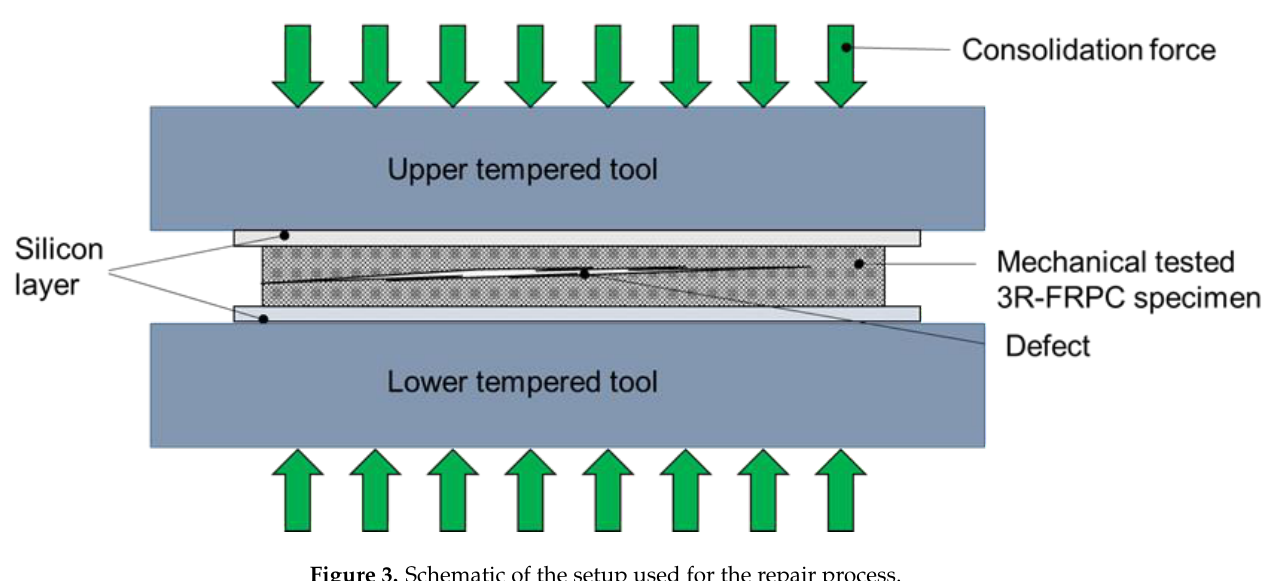
Figure 3. Schematic of the setup used for the repair process.